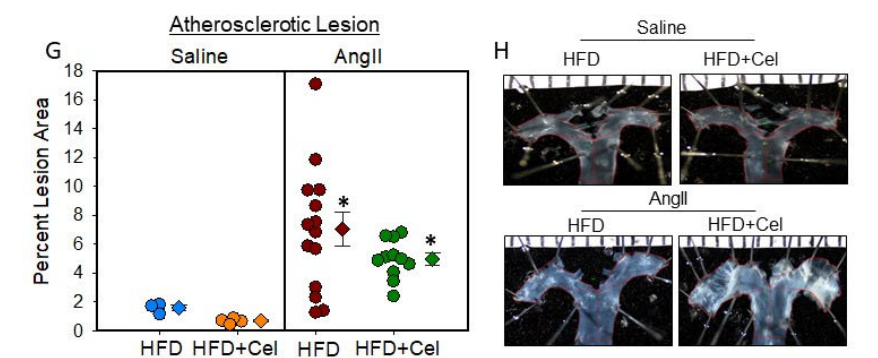
Figure 3. ( A ) Abdominal aortic luminal diameters were measured by ultrasound on weeks 0 and 4 of saline or AngII (1000 ng/kg/min) infusion in female mice (saline n = 5; AngII n = 13–15). Blue